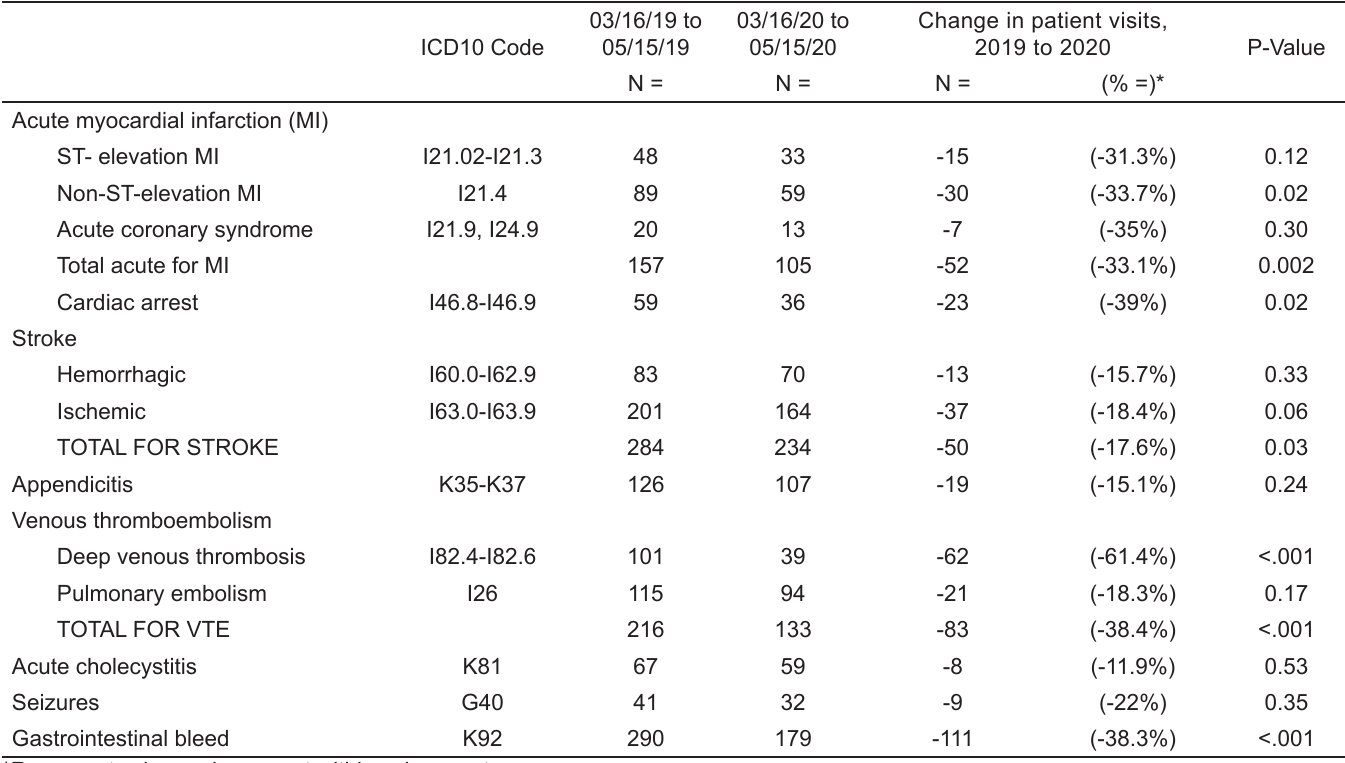
Table 3. Comparison of emergency department visits for severe illness across Johns Hopkins Health System for time period, March 16 to May 15; 2019 compared with